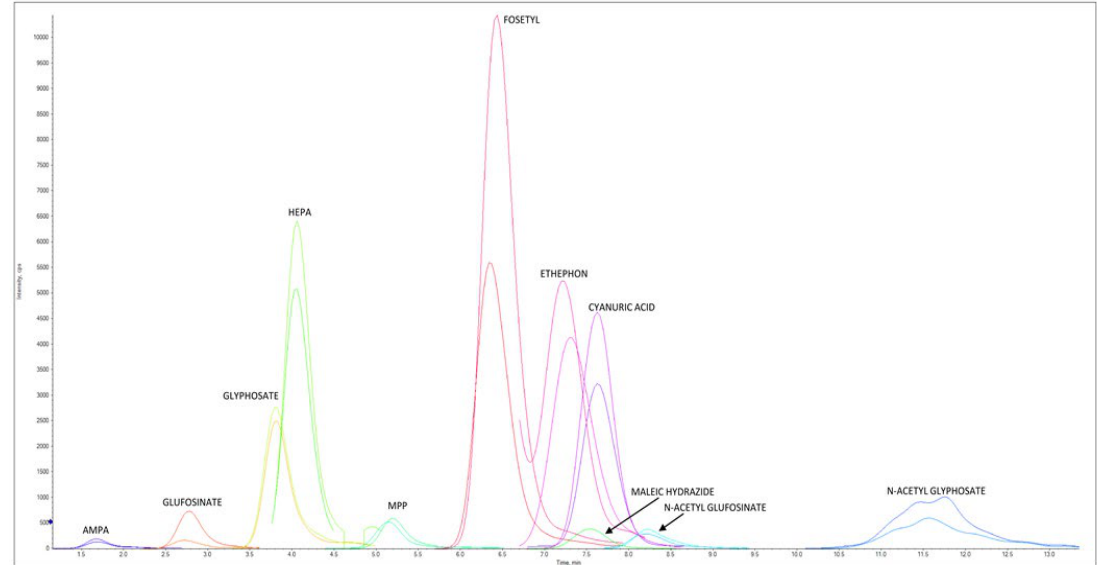
Figure 3. LC–MS/HRMS chromatogram of chicken egg extract spiked at 0.020 mg/kg for AMPA, cyanuric acid, ethephon, fosetyl Al, glyphosate, HEPA, maleic hydrazide, and N-Acetyl-glyphosate and at 0.004 mg/kg for glufosinate ammonium, MPP, and NAG. Concentration levels for ILIS were 0.006 mg/kg for AMPA- 13 C, 15 N, cyanuric acid 3 C 3 , ethephon D 4 , fosetyl Al D 15 , glyphosate 2- 13 C, 15 N, HEPA D 4 , and N-Acetyl-glyphosate 13 C 2 , 15 N, and the levels were 0.0012 mg/kg for glufosinate ammonium D 3 , MPP D 3 , and NAG D 3 . For each native pesticide and relative ILIS, one ion is reported.